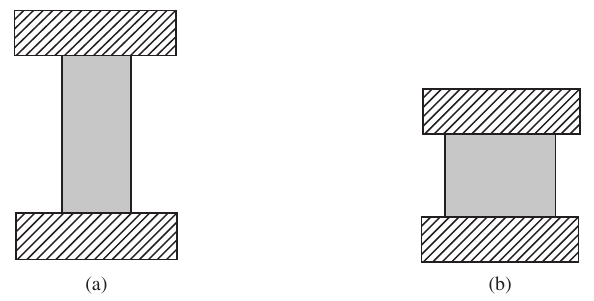
Figure 1. Behavior theoretically expected for compression test: a) before loading; and b) after